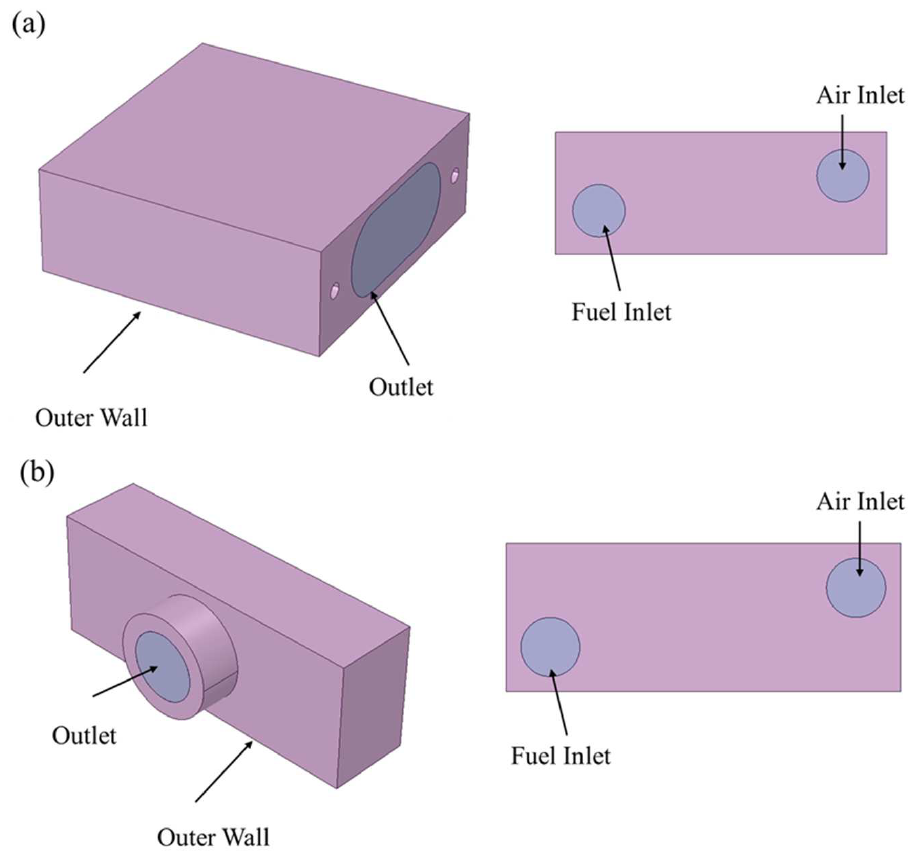
Figure 5. Computational domain and boundary condition of the simulation ( a ) horizontal vortex combustor and ( b ) vertical vortex combustor